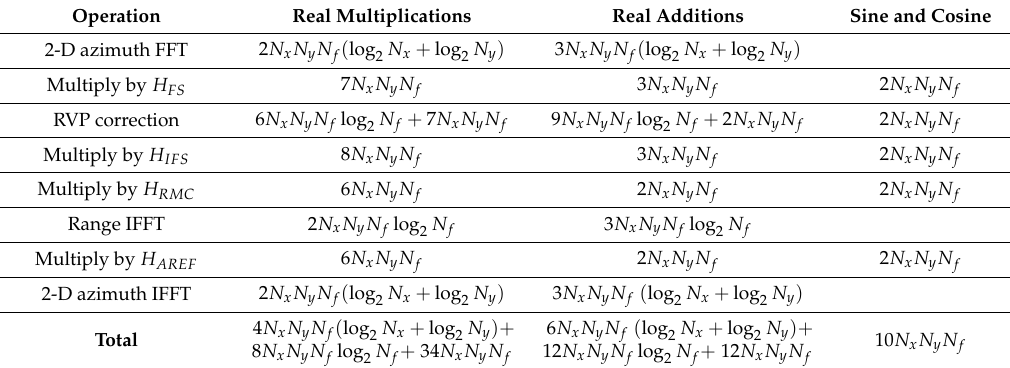
Table 1. Computational complexity of the 3-D frequency scaling algorithm. RVP = residual video phase.